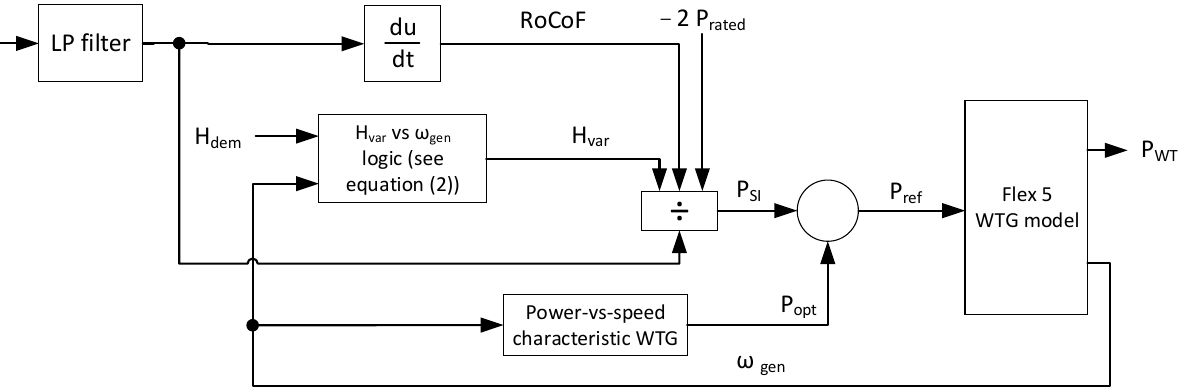
Figure 2. Power setpoint calculation and interaction with the WTG Flex5 model.